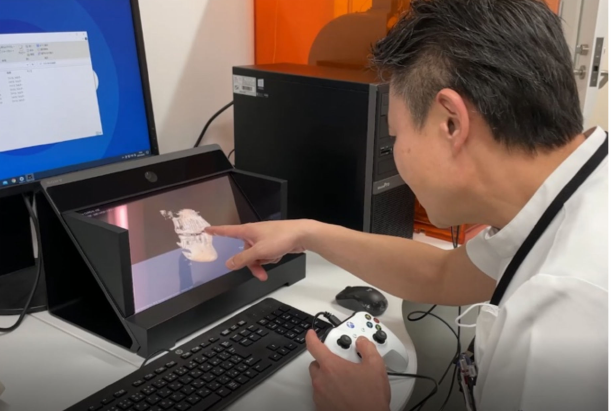
Figure 1. The SRD and a user pointing to the 3D-CG